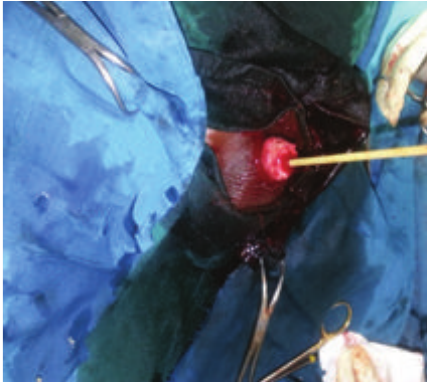
Figure 3: Penile skin shortened by 2cm and sutured into